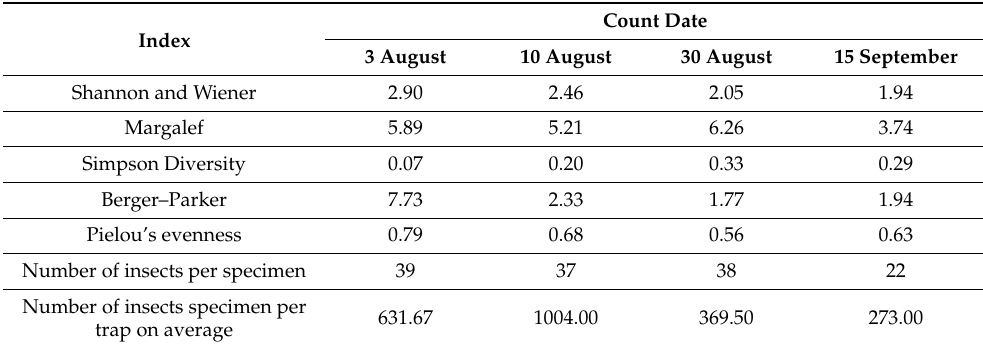
Table 2. Biodiversity analysis of soybean agrocenosis. Central zone of Krasnodar Krai.